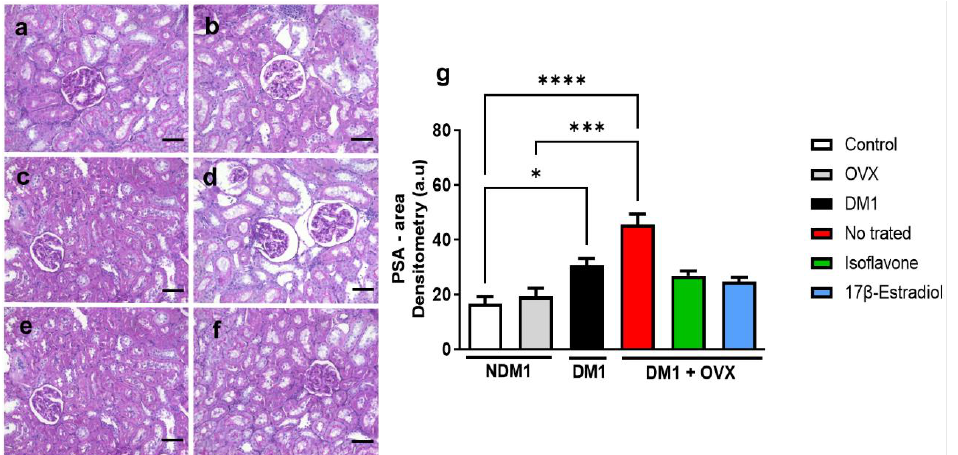
Figure 6. Isoflavone does not decrease glycogen storage in the actual tissue. Control ( a ), OVX ( b ), DM1 ( c ), DM1 + OVX untreated ( d ), DM1 + OVX treated with isoflavone ( e ), and DM1 + OVX treated with 17 β -estradiol ( f ). Densitometry analysis is represented in arbitrary units ( g ). Scale bar = 50 µ m. Values represent mean ± SEM ( n = 6). Kruskal–Wallis test was performed, followed by Dunn’s multiple comparison test for non-normal distribution of data (* p < 0.05; *** p < 0.001; **** p <